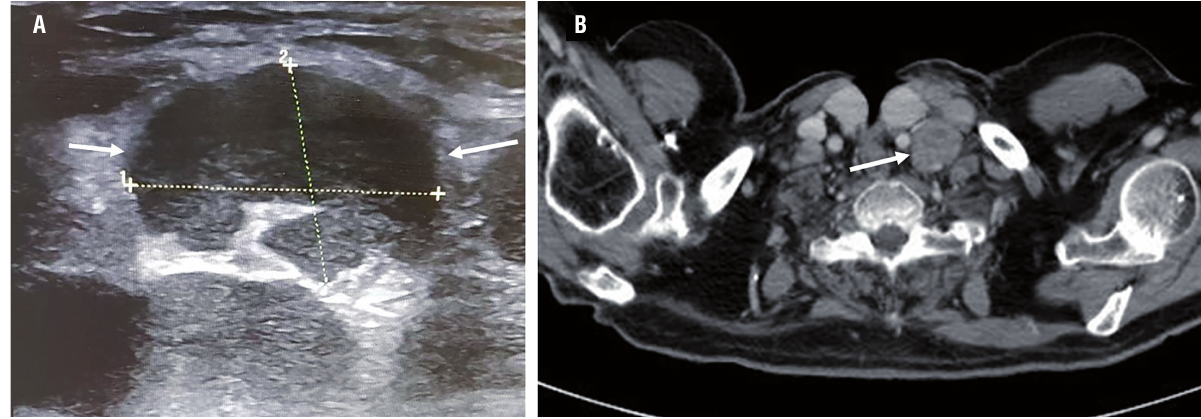
Figure 3 - (A) Ultrasound of the left supraclavicular region and (B) contrast-enhanced computed tomography scan showing enlarged left supraclavicular LNs